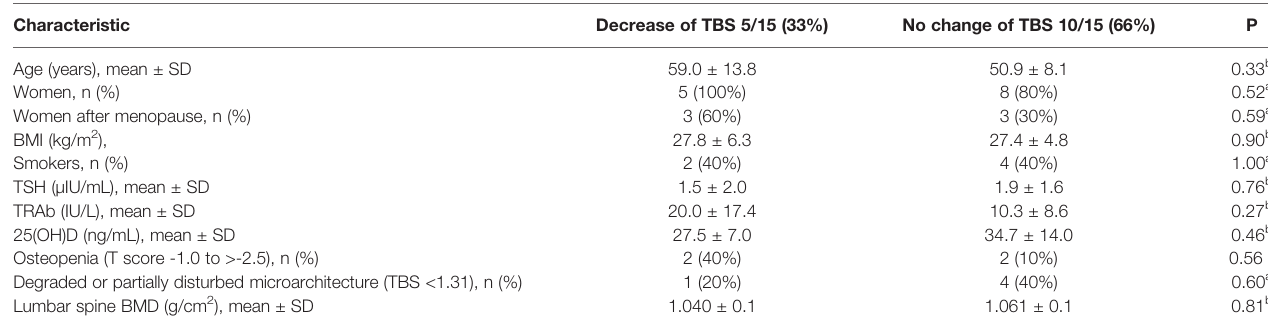
TABLE 4 | Comparison of selected baseline characteristics of patients with and without decrease of trabecular bone score (TBS) (decrease in TBS equal to or exceeding the least signi fi cant change) after intravenous methylprednisolone therapy. Characteristic